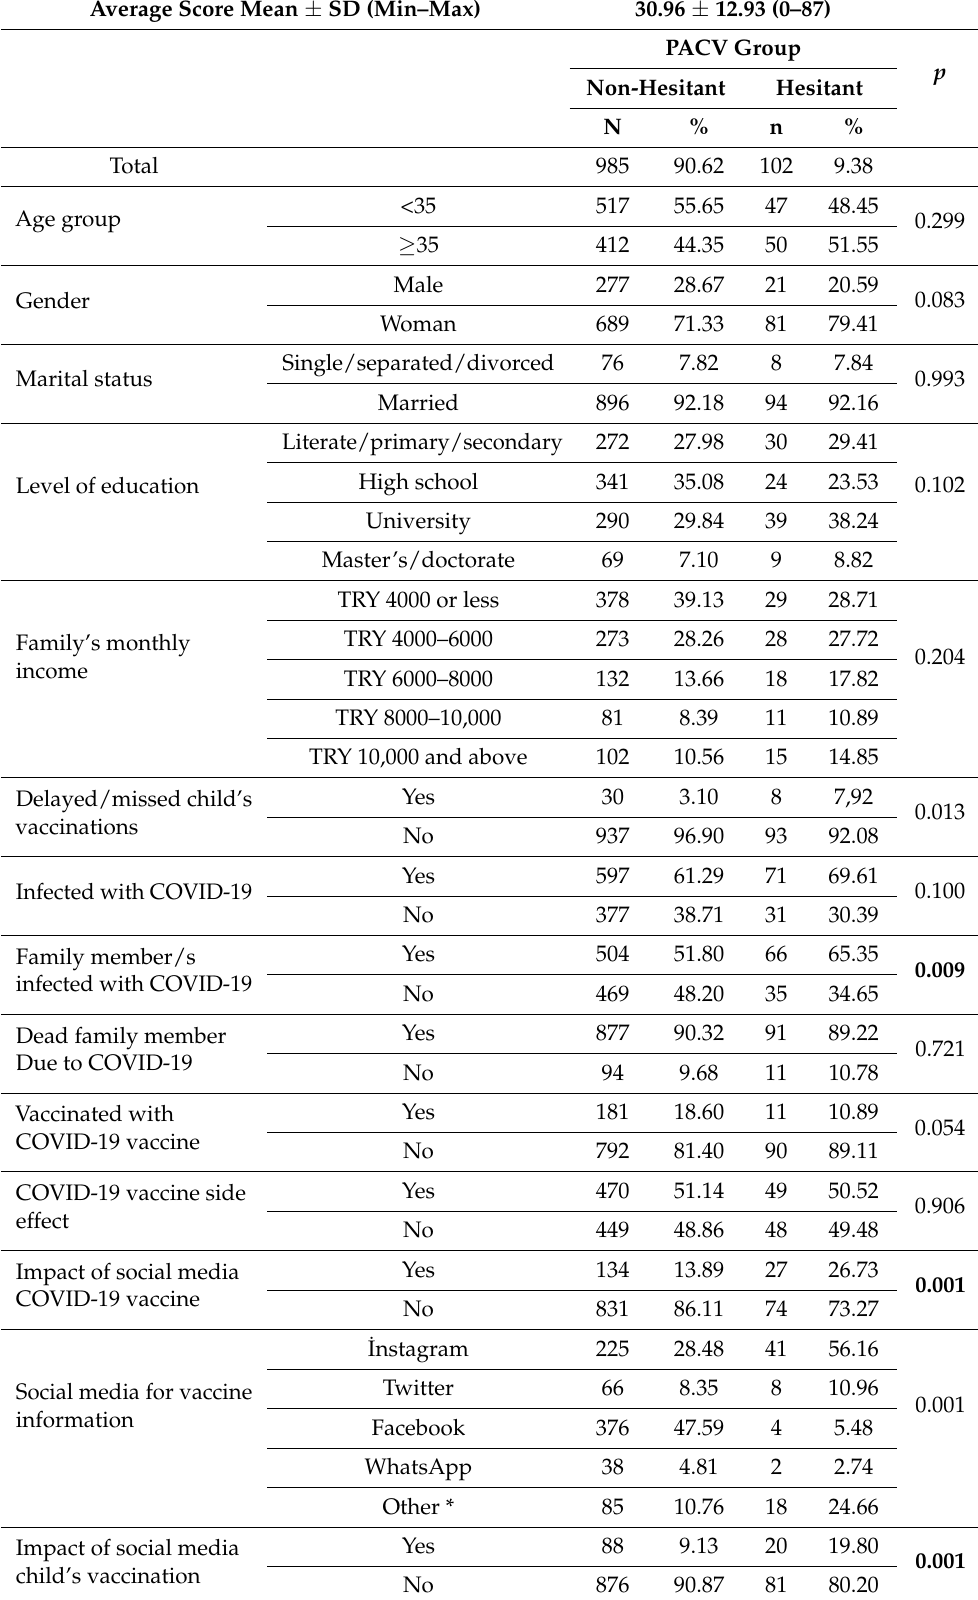
Table 2. The Relationship between Parental Attitudes about Childhood Vaccines and Characteristics of Participating